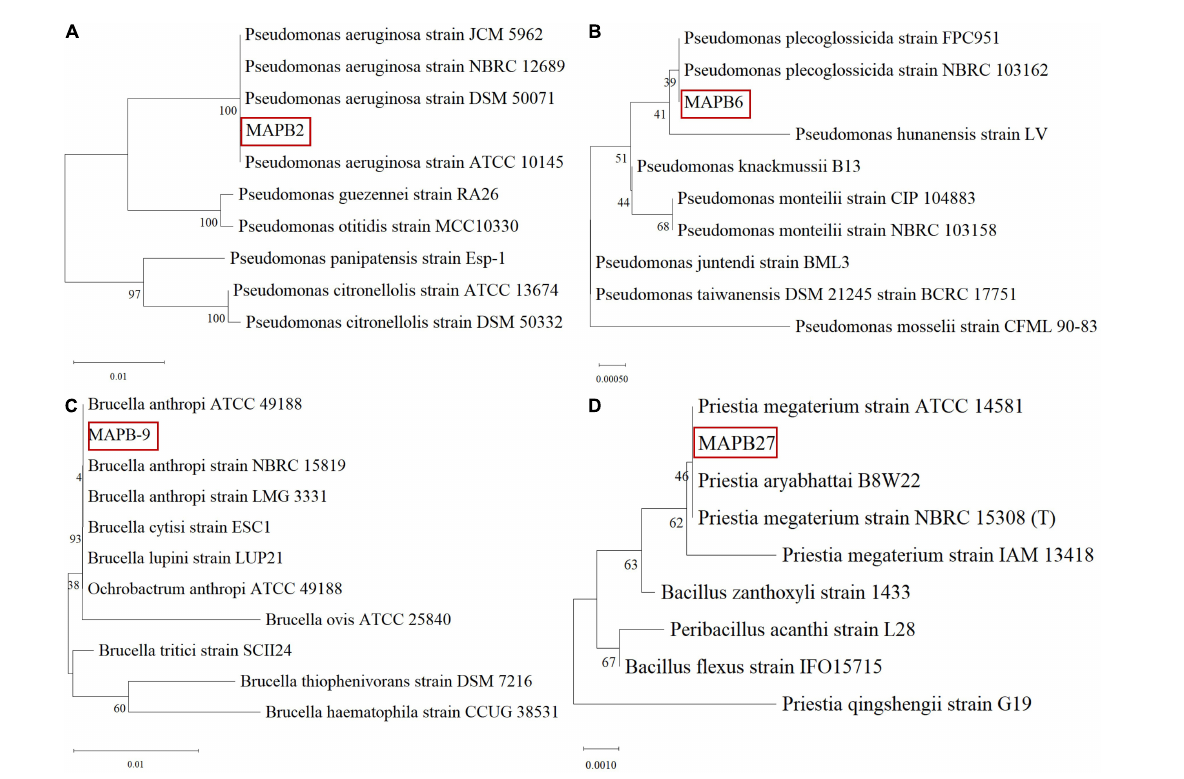
FIGURE1 Phylogenetic tree by Maximum Likelihood method and Kimura 2-parameter model based on 16S rRNA gene sequences (A) MAPB-2, (B) MAPB-6, (C) MAPB-9, and (D) MAPB-27. Bootstrap values (expressed as percentages generated from 1,000 replicates) are shown at branch